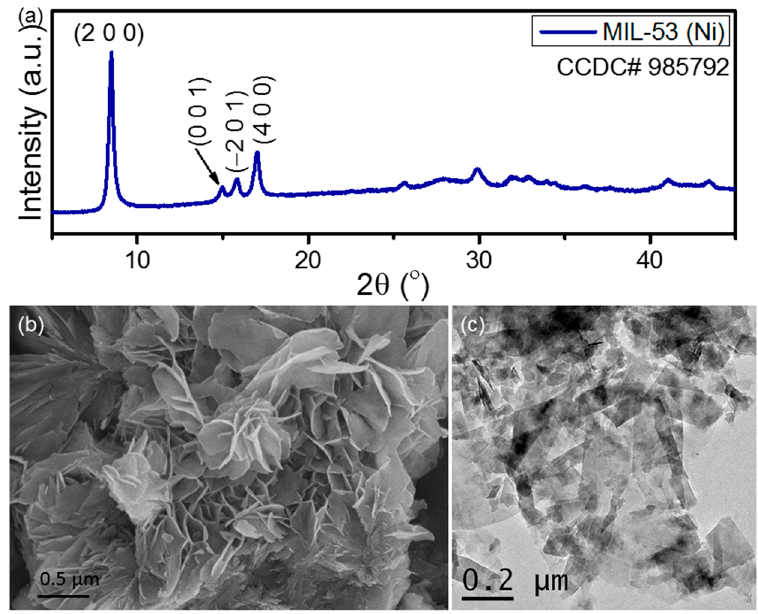
Figure 1. ( a ) XRD pattern, ( b ) SEM micrograph, and ( c ) bright field TEM image of the synthesized Ni-MOF nanosheets.